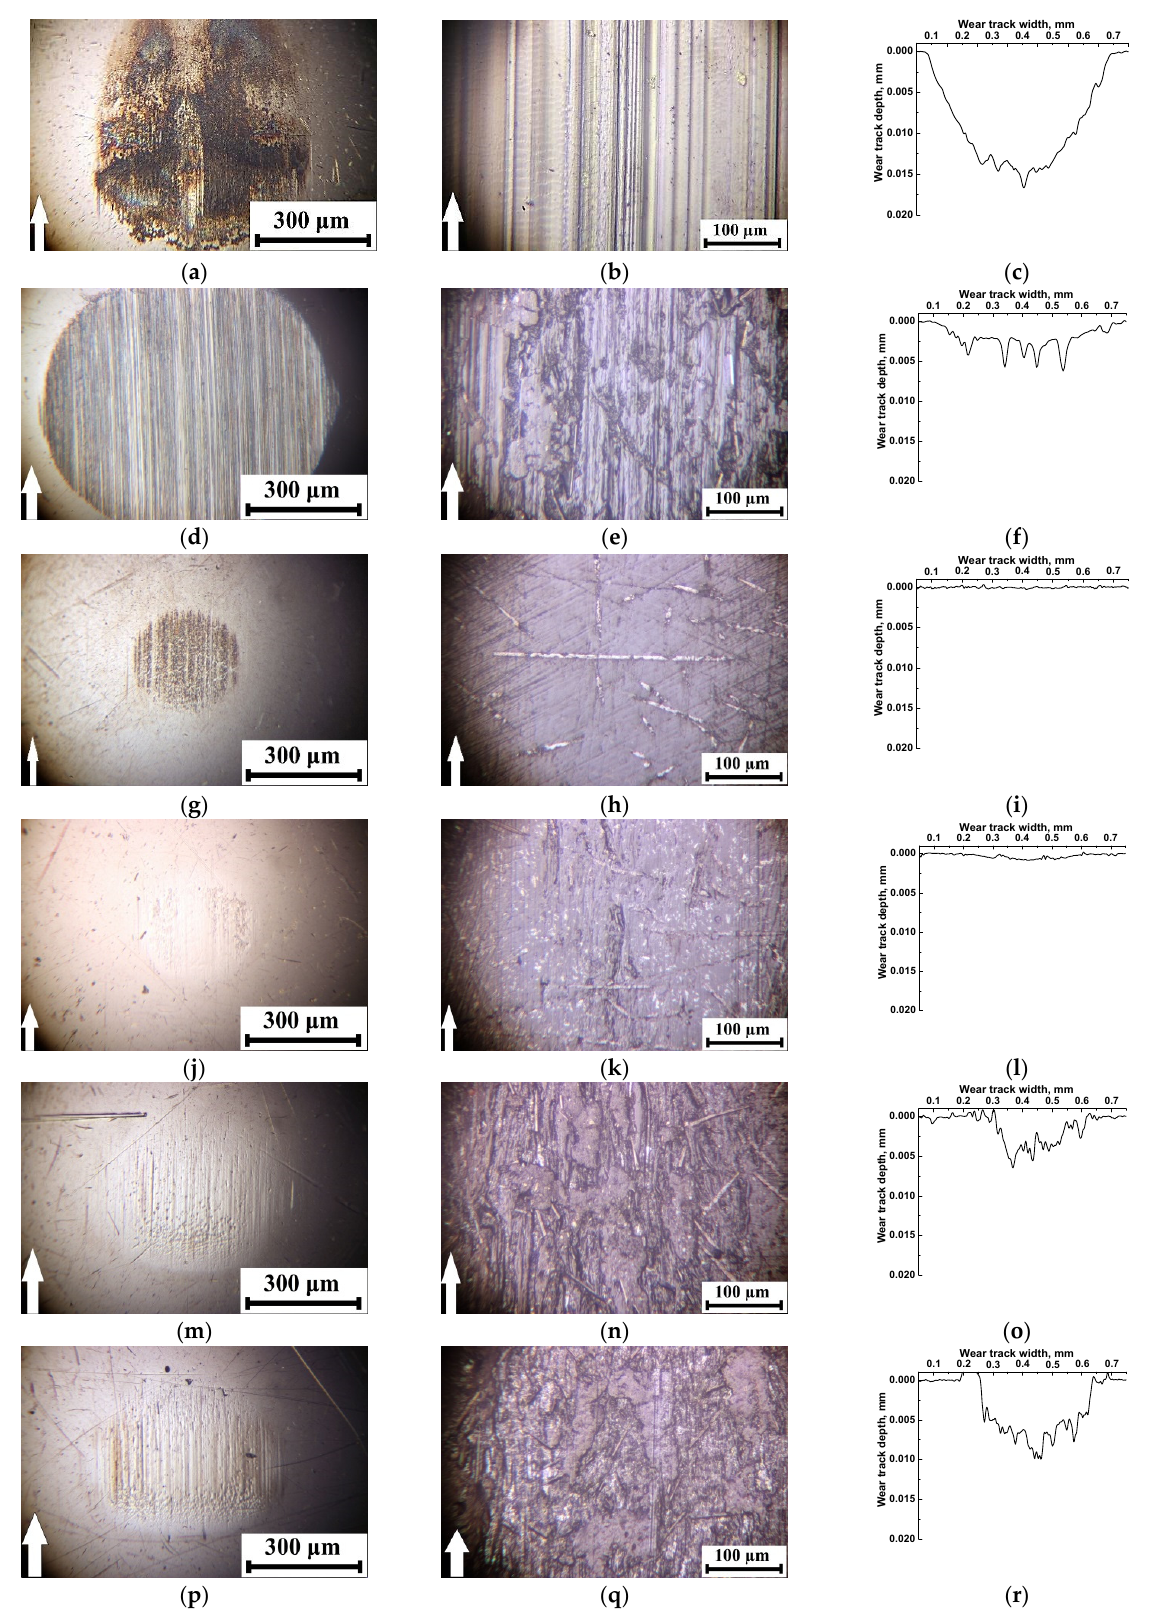
Figure 6. The optical images of the friction surfaces on the metal counterpart and neat PI ( a – c ), as well as the PI/10CCF ( d – f ), PI/10CCF/10PTFE ( g – i ), PI/10CCF/10Gr ( j – l ), PI/10CCF/10MoS 2 ( m – o ), and PI/10CCF/23MoS 2 ( p – r )